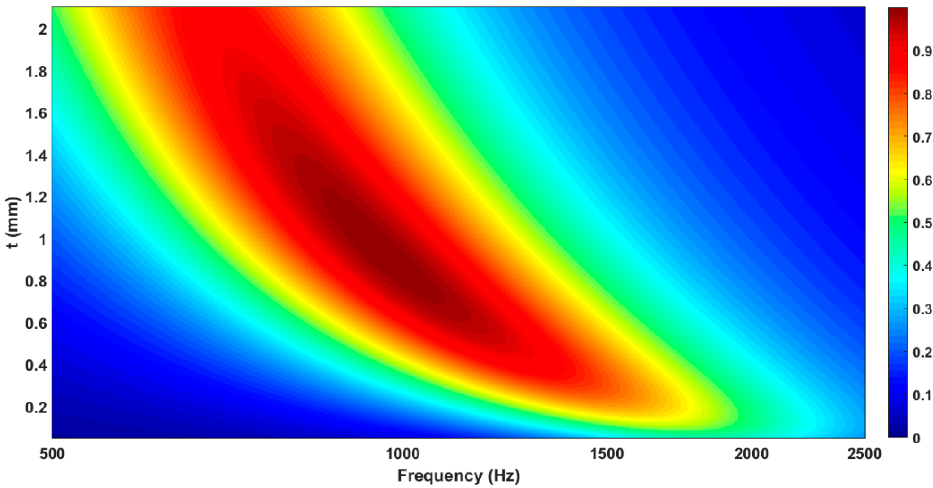
Figure 7. Absorption coefficient of an SL-MPP as a function of ( f , t ) for ( d , φ , D ) = (0.4 mm,1%,2 cm).